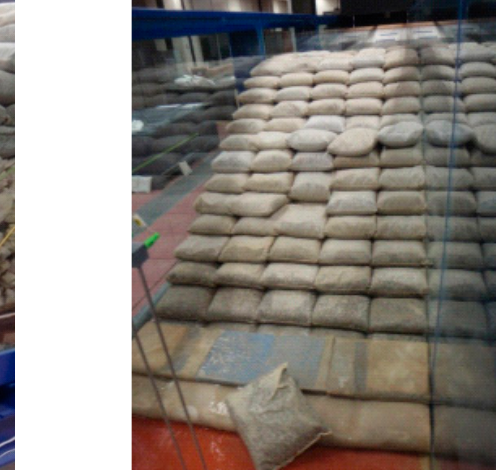
Figure 20. Configuration with slope 1:2. Sliding of some elements in the stability test with H = 0.20 m, T = 2.0 s and h = 0.40 m ( left panel ) and removal of elements in the stability test with H = 0.20 m, T = 3.0 s and h = 0.40 m ( right panel ).